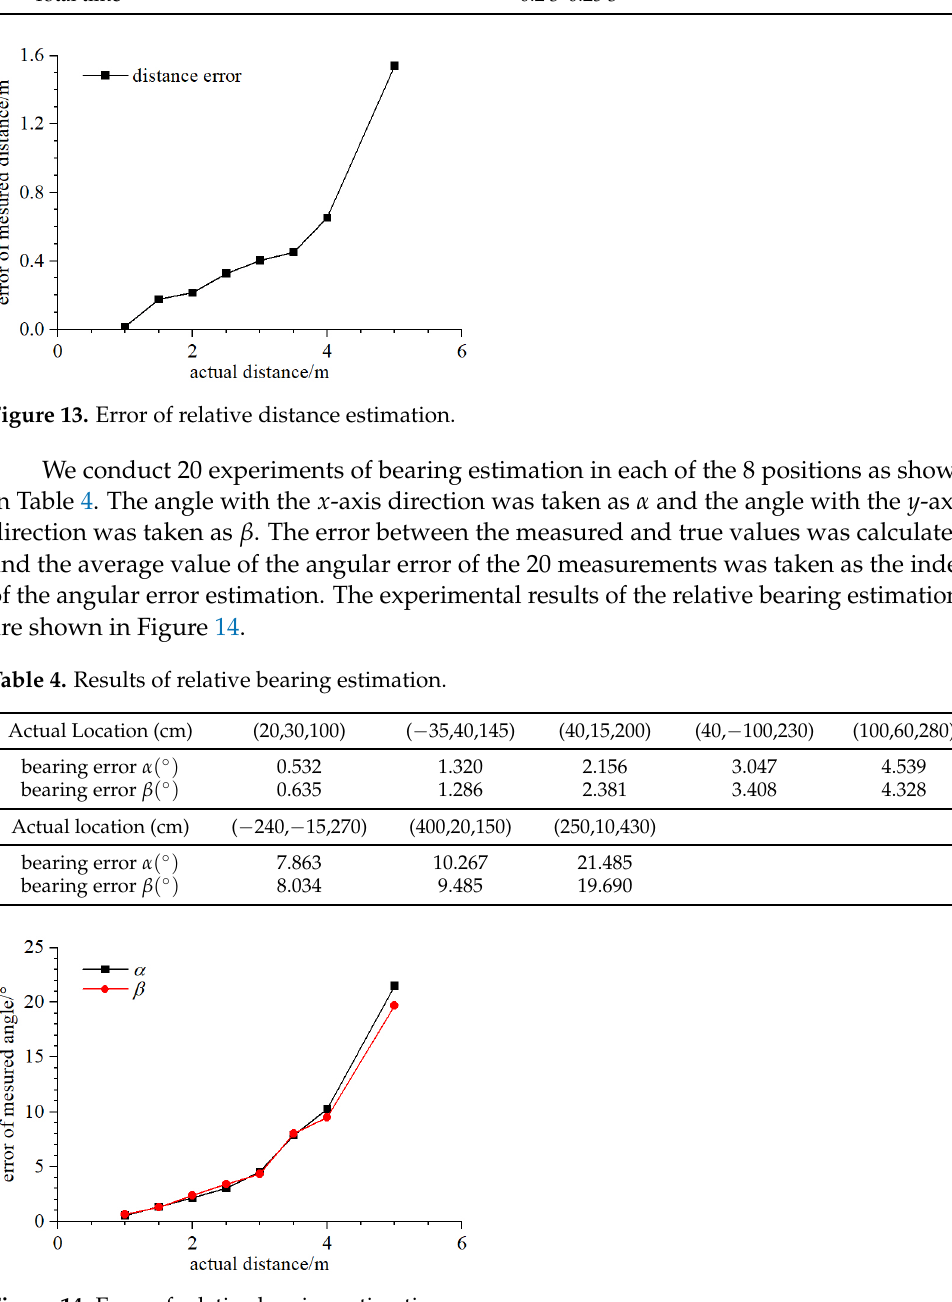
Figure 14. Error of relative bearing